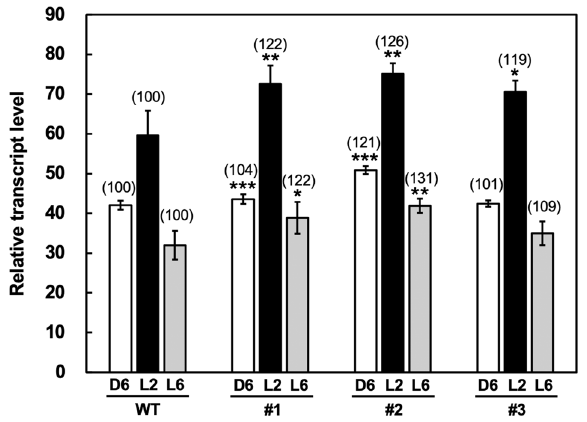
Figure 2. RDD1 transcript levels in the shoots of the wild-type (WT) and R1 -Cas #1–3 plants at the 4-leaf stage. The plants were grown in a low concentration hydroponic nutrient solution under normal conditions and harvested 2 h before (D6), and 2 h (L2), and 6 h (L6) after the onset of illumination. The transcript levels are normalized to those of RUBQ2 , and the highest transcript level is defined as 100. Data are presented as the average ± standard error of the mean ( n = 8). Asterisks indicate significant differences relative to the WT plants based on the Student’s t -test (* p < 0.05, ** p < 0.01, and *** p < 0.001). At the time of each harvest, the values relative to those of the WT as 100 are shown in